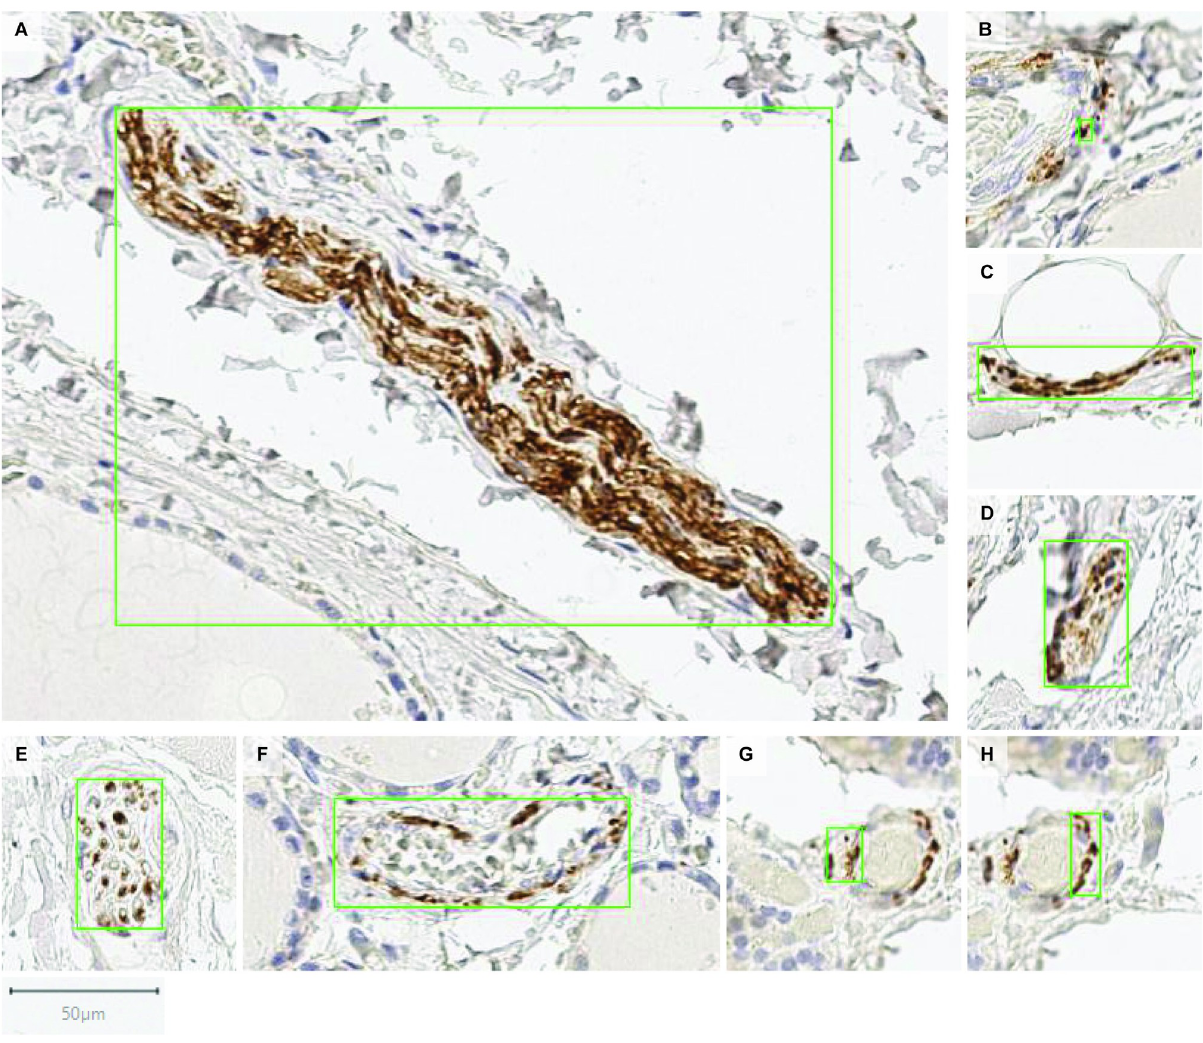
Fig 14. Examples of nerves detected (i.e. true positives, TP a ) by the proposed CNN based approach. Each image patch contains one prediction instance indicated by a green